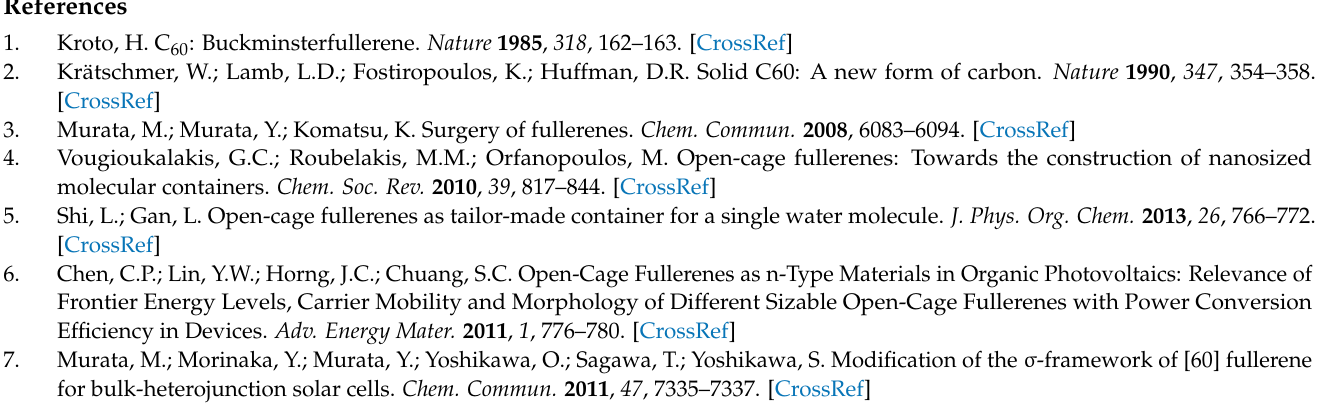
DMA; Figure S2: 1 H NMR spectra of H 2 @C 60 with 1 eq DMA; Figure S3: 1 H NMR spectra of H 2 @C 60 with 1.5 eq DMA; Figure S4: 1 H NMR spectra of H 2 @C 60 with 2 eq DMA; Figure S5: 1 H NMR spectra of H 2 @C 60 with 15 eq DMA; Figure S6: 1 H NMR spectra of H 2 @C 60 with 20 eq DMA; Figure S7: 1 H NMR spectra of H 2 @C 60 with 10 eq